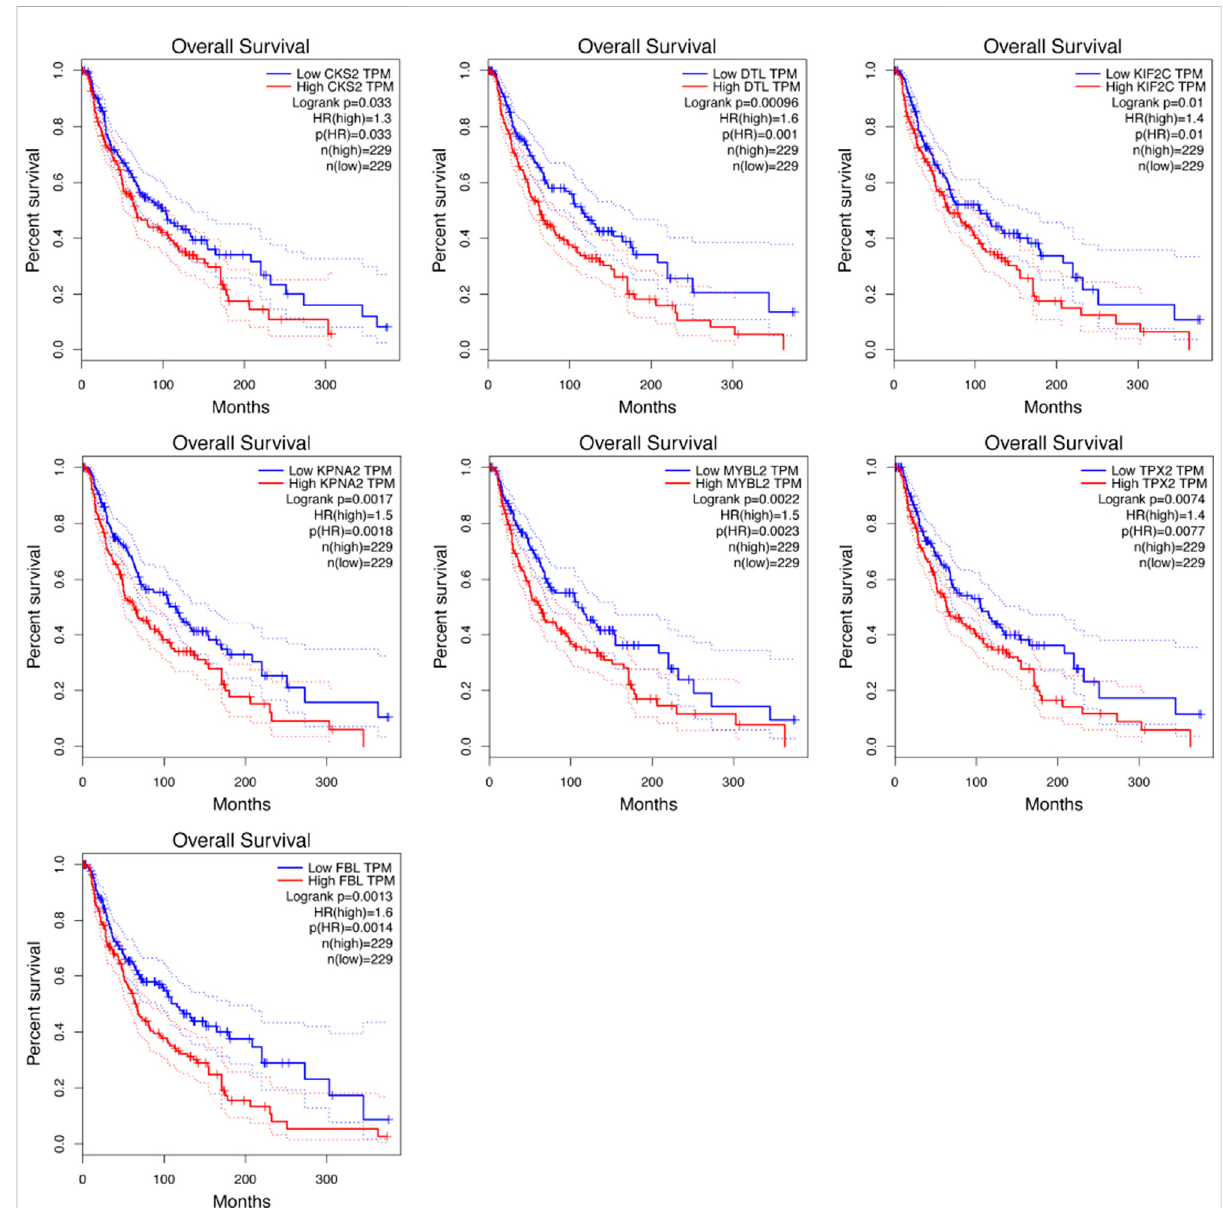
FIGURE 5 Survival analysis of the hub genes was performed using Kaplan-Meier curve. Each elevated expression in seven hub genes showed markedly signi fi cant worse OS inmelanoma samples ( p <